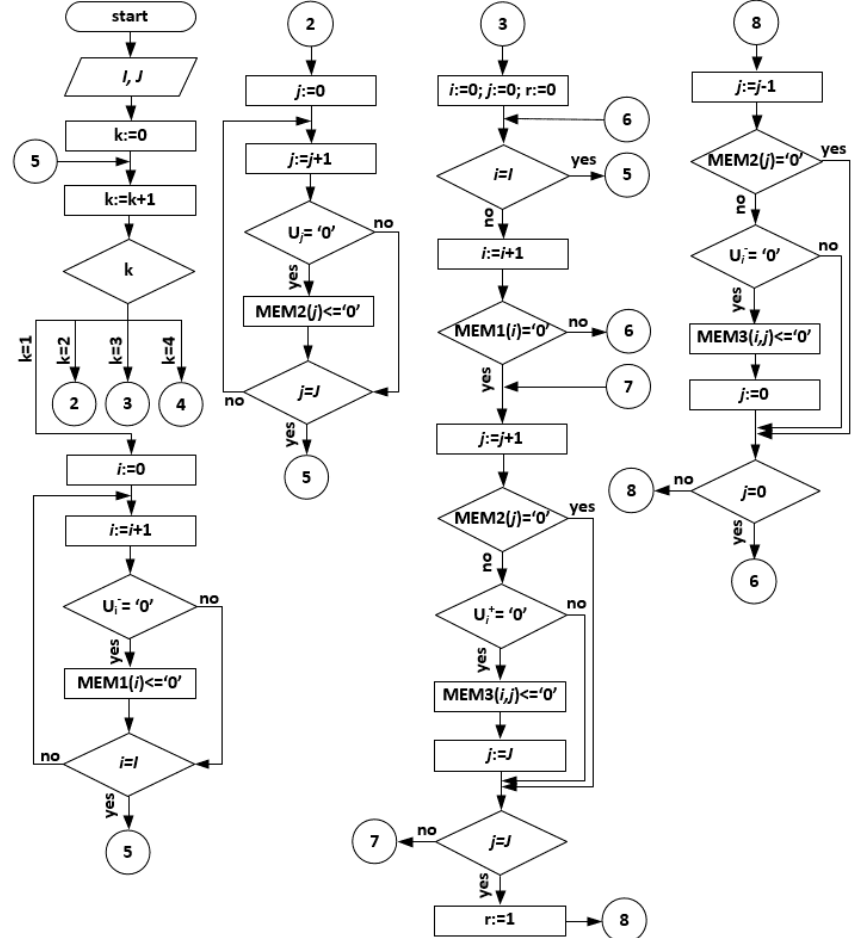
Figure 2. Operation algorithm of the surface defect monitoring system. Part I.